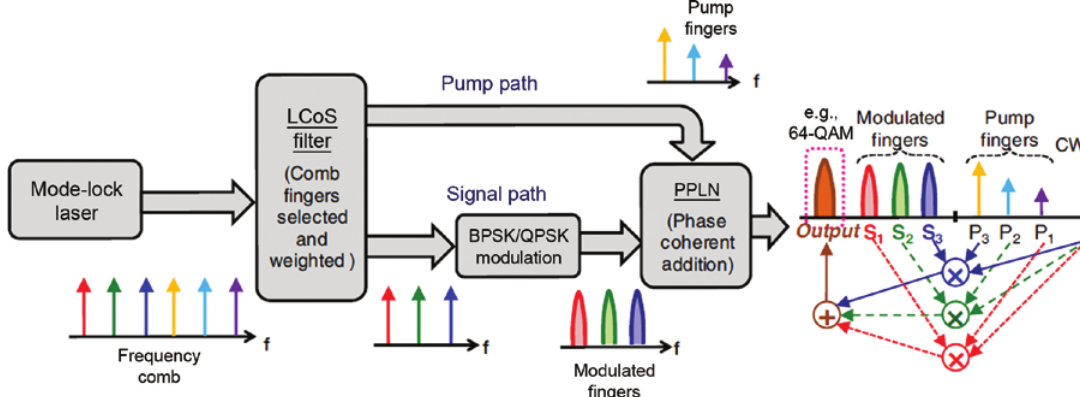
Figure 29: Aggregation concept.